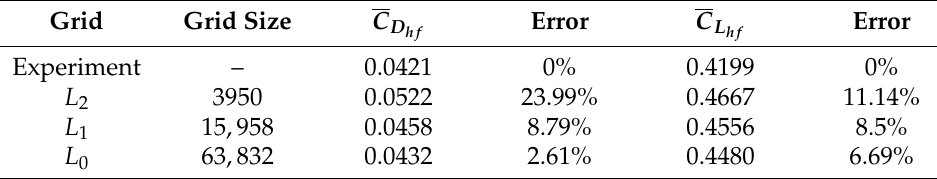
Figure 10. Supercavity over Waid-Lindberg profile. Table 4. Grid convergence study and